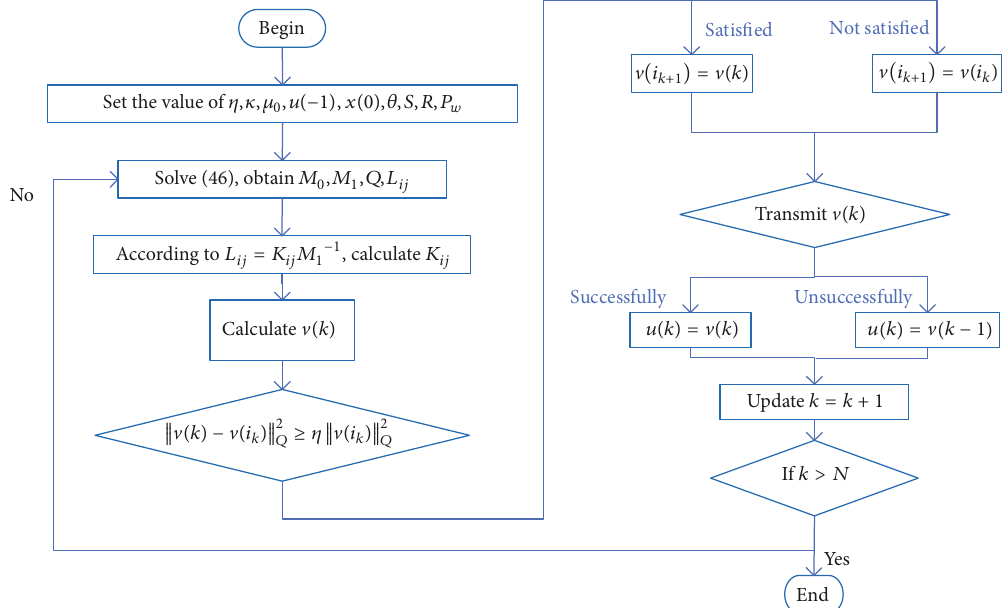
Figure 2: The completed procedure of Algorithm